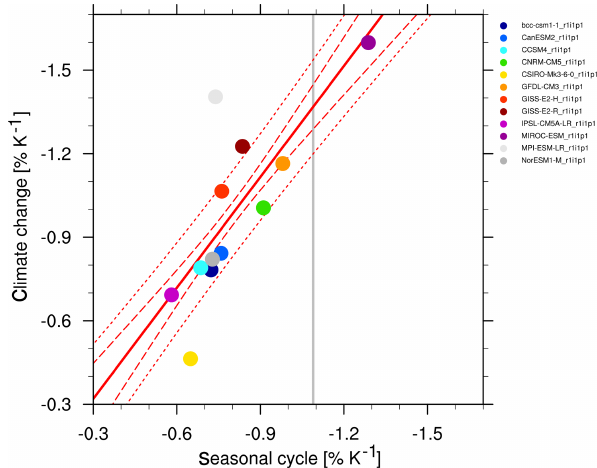
Figure 12. Scatter plot of springtime snow-albedo effect values in climate change (ordinate) vs. springtime (cid:49)α s /(cid:49)T s values in the seasonal cycle (abscissa) in transient climate change experi- ments calculated from CMIP5 historical (1901–2000) and RCP4.5 (2101–2200) experiments. The vertical gray line shows the seasonal cycle values calculated from third generation of ISCCP radiative fluxes (ISCCP-FH, Young et al., 2018) and near-surface air tem- perature from ERA-Interim (Dee et al., 2011) for the years 1984– 2000. Models with higher surface albedos over NH continents poleward of 30 ◦ N typically have a larger contrast between snow- covered and snow-free areas, and hence a stronger snow-albedo feedback. Similar to Fig. 9.45a of Flato et al. (2013); for details on recipe_snowalbedo.yml , see Sect.